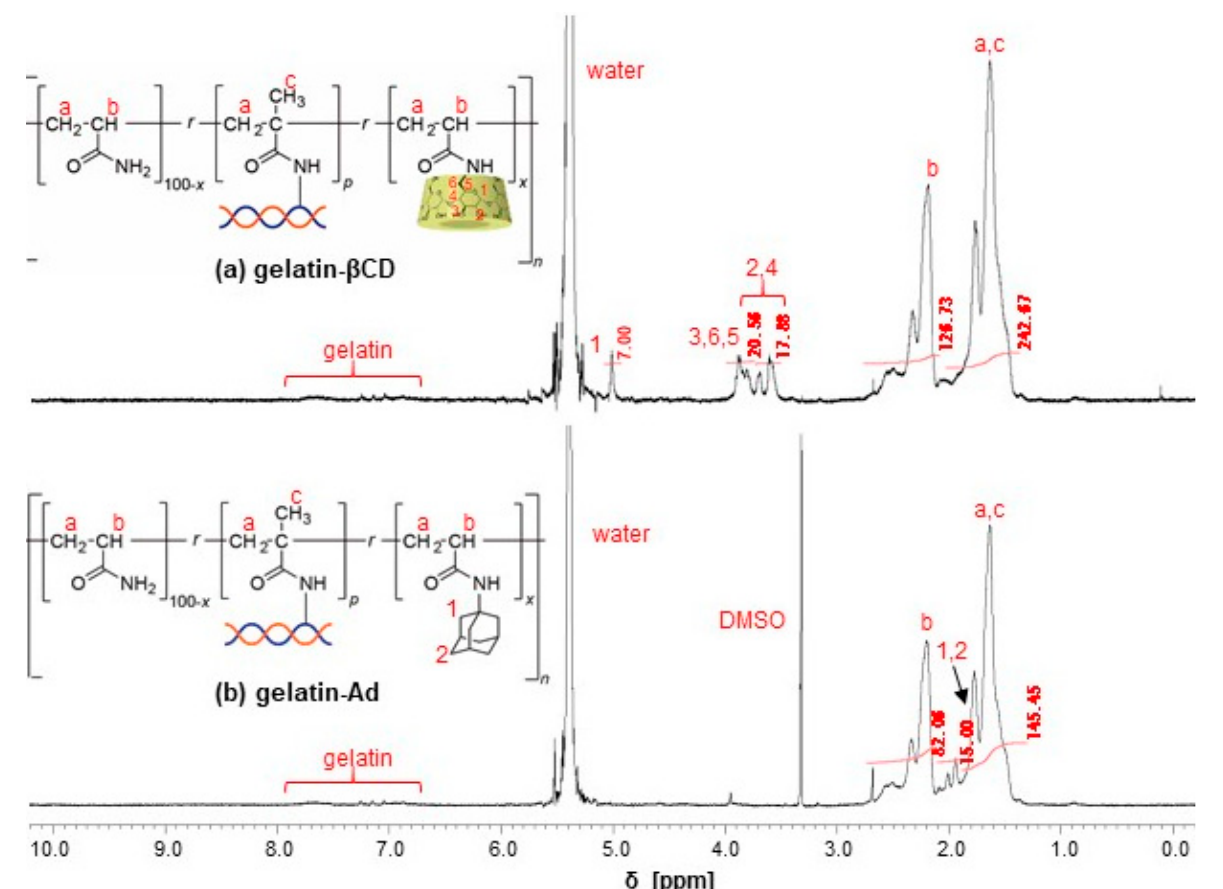
Figure 2. 1 H NMR spectra of ( a ) β CD-gelatin and ( b ) Ad-gelatin in D 2 O containing trifluoroacetic acid (12.5 v / v %), acquired on a 500 MHz JEOL ECA-500 NMR spectrometer at 30 °C. Chemical shifts were referenced to -C H - of the main chain as the standard (b position, δ = 2.2 ppm). Peaks a-c correspond to the main-chain protons, whereas peaks 1–6 correspond to CD and Ad protons.